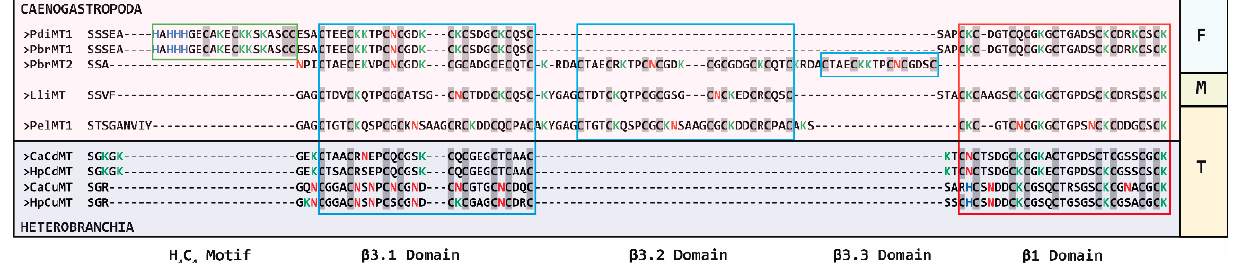
Figure 1. Amino acid alignment of P. bridgesii MTs (PbrMT1 and PbrMT2) sequences with other gastropod MTs from species of Caenogastropoda (pink background) and Heterobranchia (purple background) classes (SRA accession number/UniProt accession number): P. diffusa PdiMT1 (SRX3488051_2_SRX644696), L. littorea LliMT (Q962G0), P. elegans PelMT1 (KY646305), C. aspersus CaCdMT (A1YZ80; a.k.a. HasMT2) and CaCuMT (A2I9Y4; a.k.a. HasMT1) and H. pomatia HpCdMT (P33187; a.k.a. HpoMT2) and HpCuMT (P55947; a.k.a. HpoMT1). β 3-domains are boxed in blue, β 1-domain in red, and the H 4 C 4 motif in green. Cysteines are highlighted with a grey background, histidines are colored in blue, lysines in green, and asparagines in red. Colored boxes at the right side of the alignment indicate the habitats of the selected species: in light blue for freshwater (F) habitats, in light green for marine (M) habitats, and in light brown for terrestrial (T) habitats.